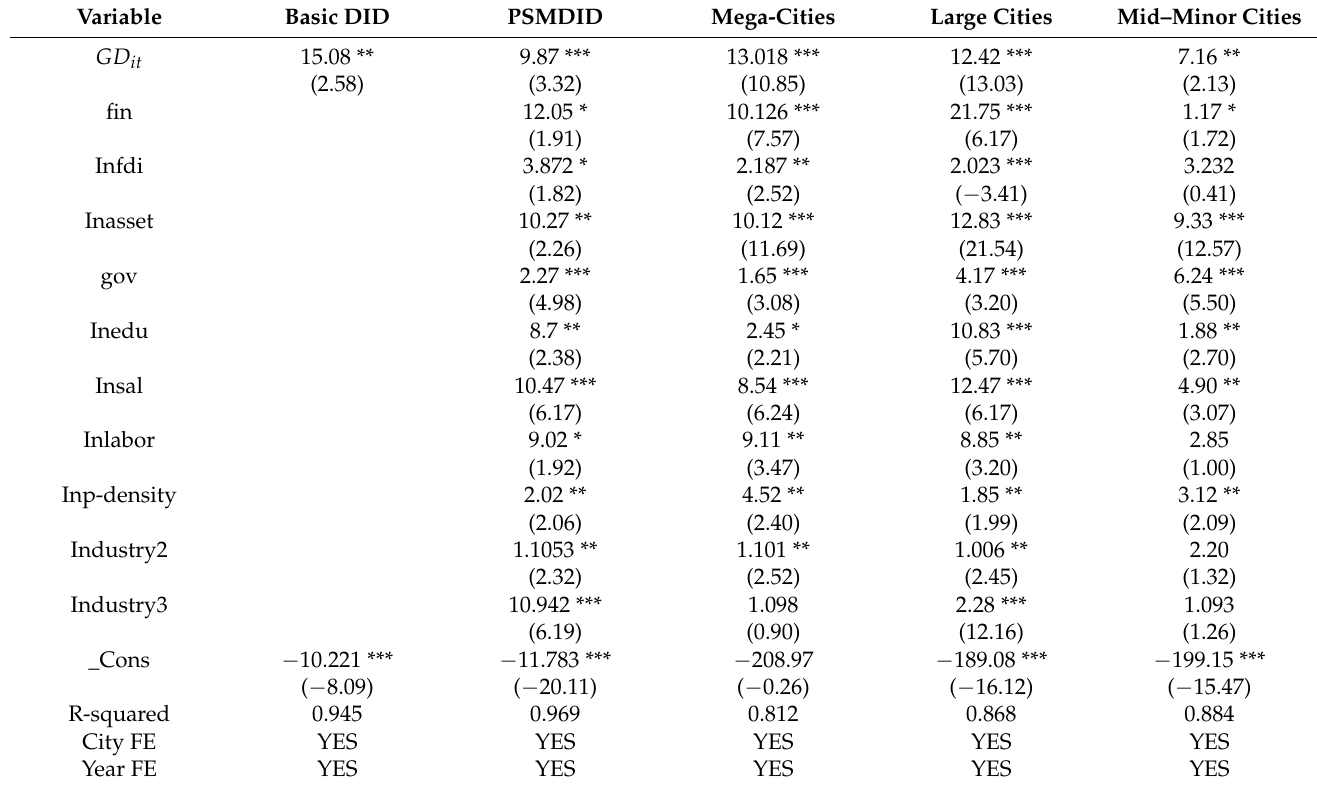
Table 4. Regression analysis of urban innovation bonus (talent